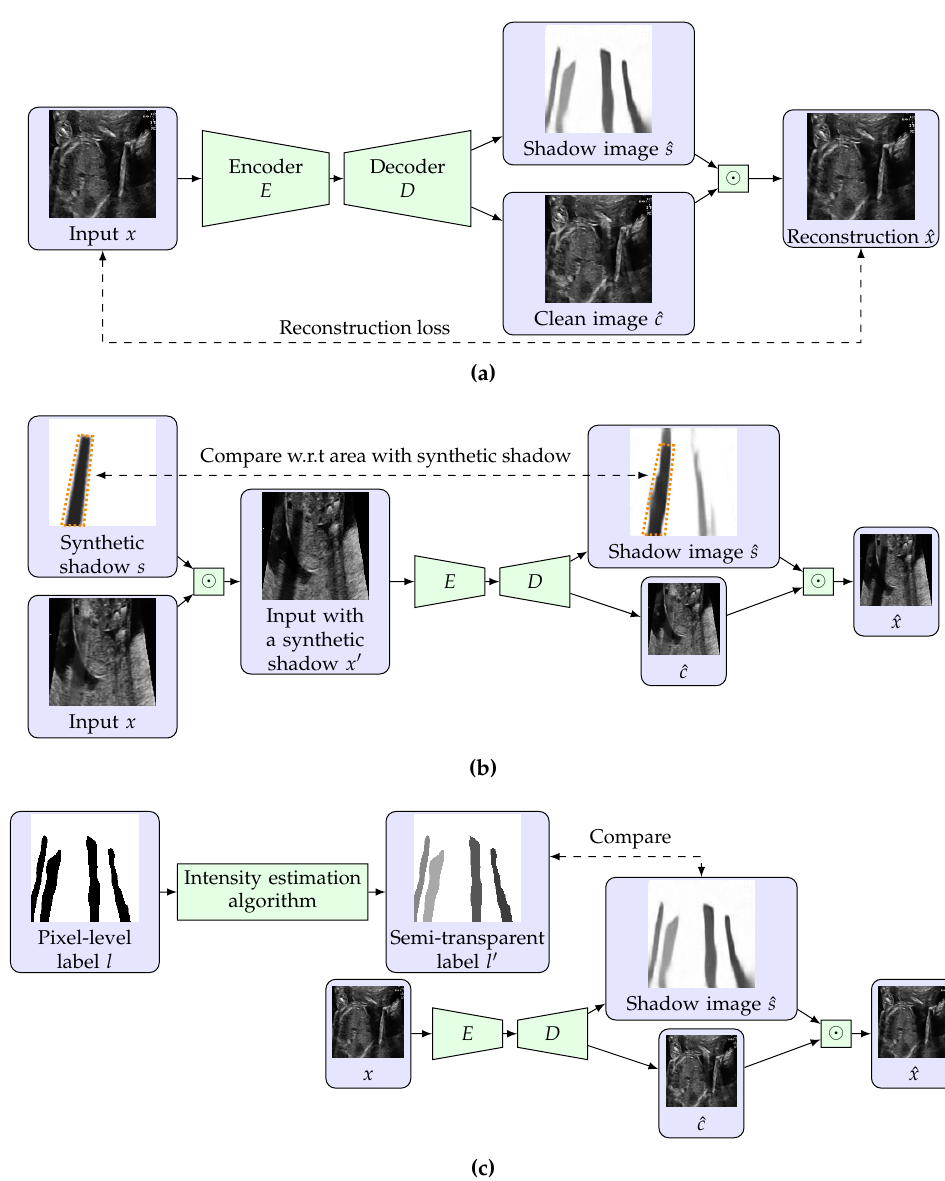
Figure 1. Overview of our shadow estimation method. (a) shows the proposed auto-encoding structure. (b) and (c) illustrate the learning process for unlabeled data and pixel-level labeled data, respectively. For unlabeled data, the estimated shadow ˆ s is compared to the synthetic shadow with respect to the region that the synthetic shadow exists. For labeled data, the label is made semi-transparent based on the estimated intensity of labeled shadows, and ˆ s is compared to it.